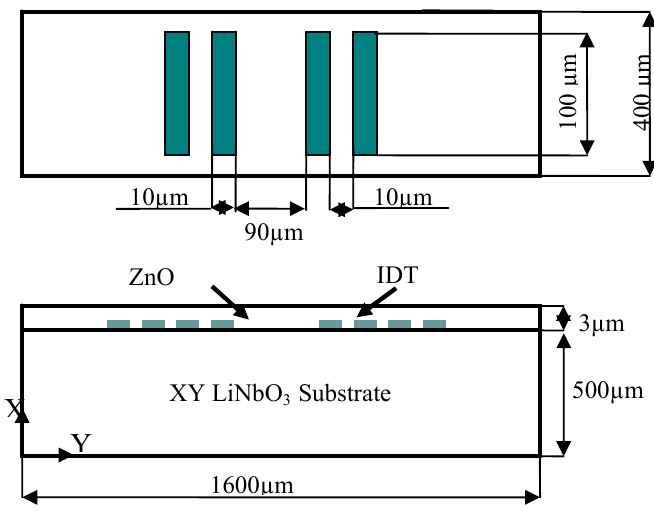
Figure 2. Schematic of the ZnO-XY LiNbO